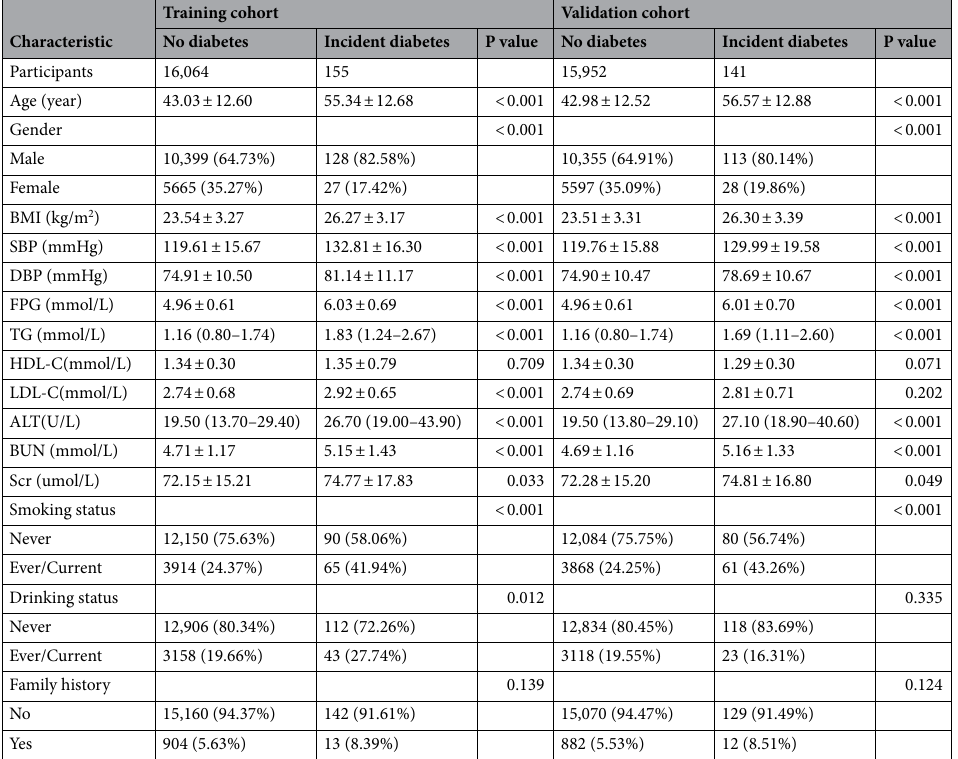
Table 2. Baseline characteristics for the training and validation cohorts by incident diabetes status. Values are n (%) or mean ± SD. SD, Standardized difference; BMI, Body mass index; SBP, Systolic blood pressure; DBP, Diastolic blood pressure; FPG; Fasting plasma glucose; TG, Triglyceride; HDL-C, High-density lipoprotein cholesterol; LDL-C, Low-density lipid cholesterol; ALT, Alanine aminotransferase; BUN, Blood urea nitrogen; Scr, Serum creatinine; Family history, Family history of